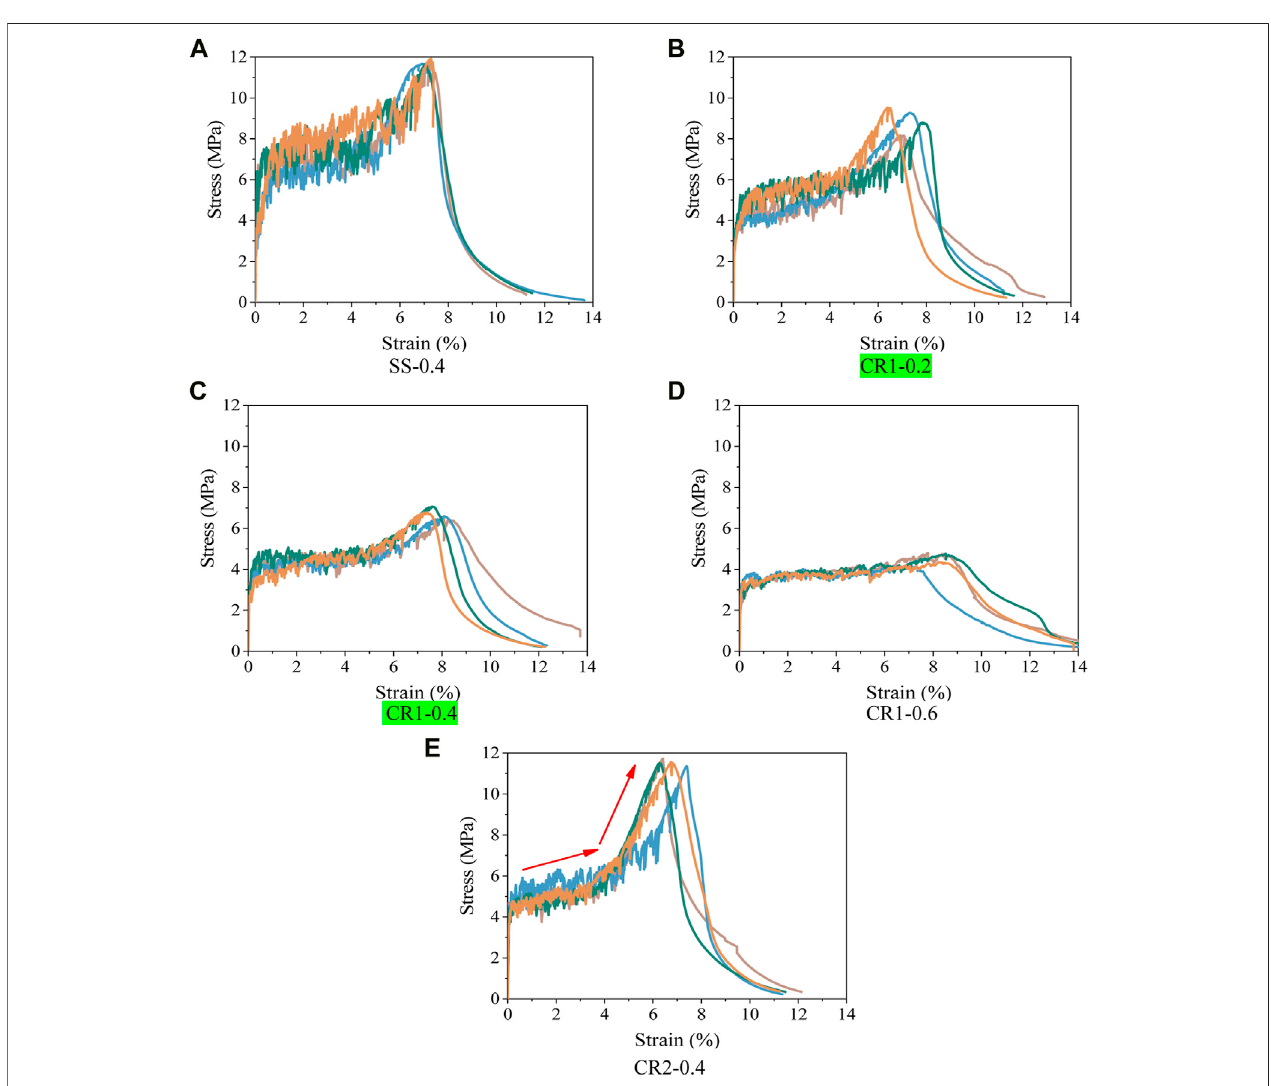
FIGURE 5 | Tensile stress – strain curves of HS-ECC. (A) SS-0.4. (B) CR1-0.2. (C) CR1-0.4. (D) CR1-0.6. (E) CR2-0.4. HS-ECC, high-strength engineered cementitious composite.